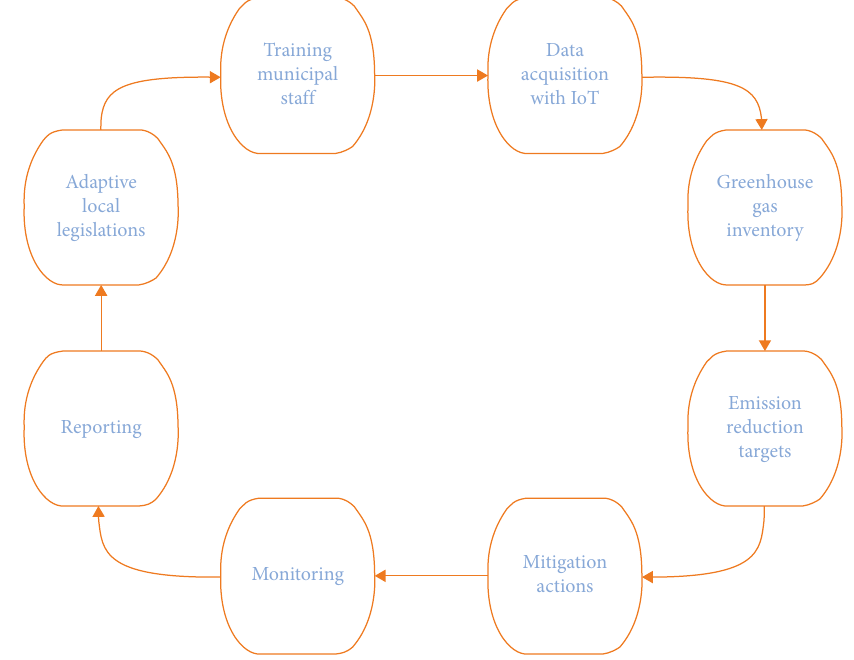
Figure 9: The proposed local climate change policy cycle (the fi gure is created and proposed by the author).